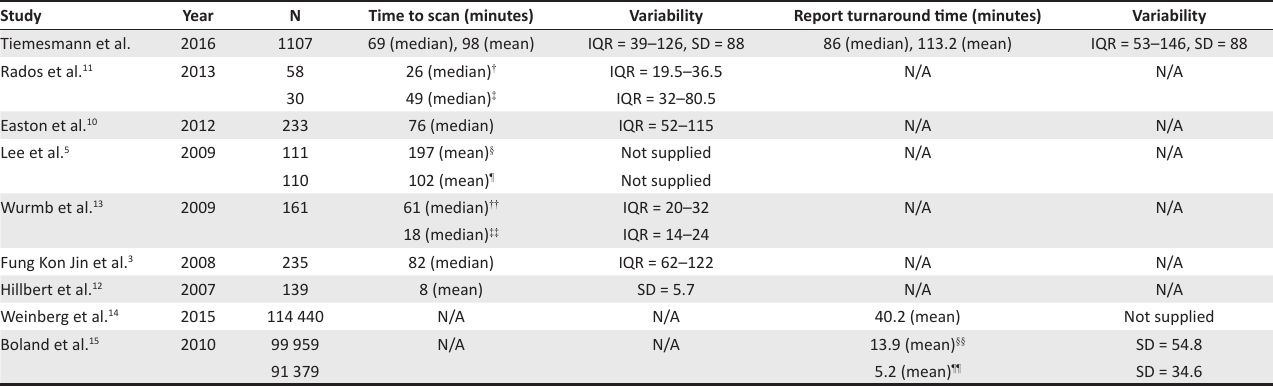
TABLE 3: Comparison with previous